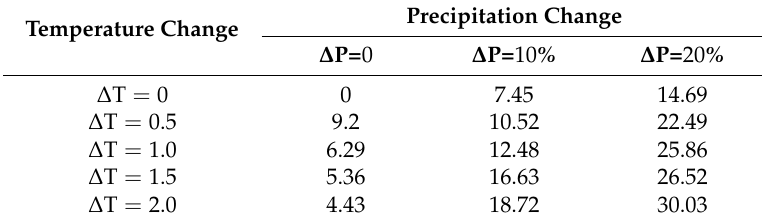
Table 10. Response of runoff to simultaneous increase in temperature and precipitation.